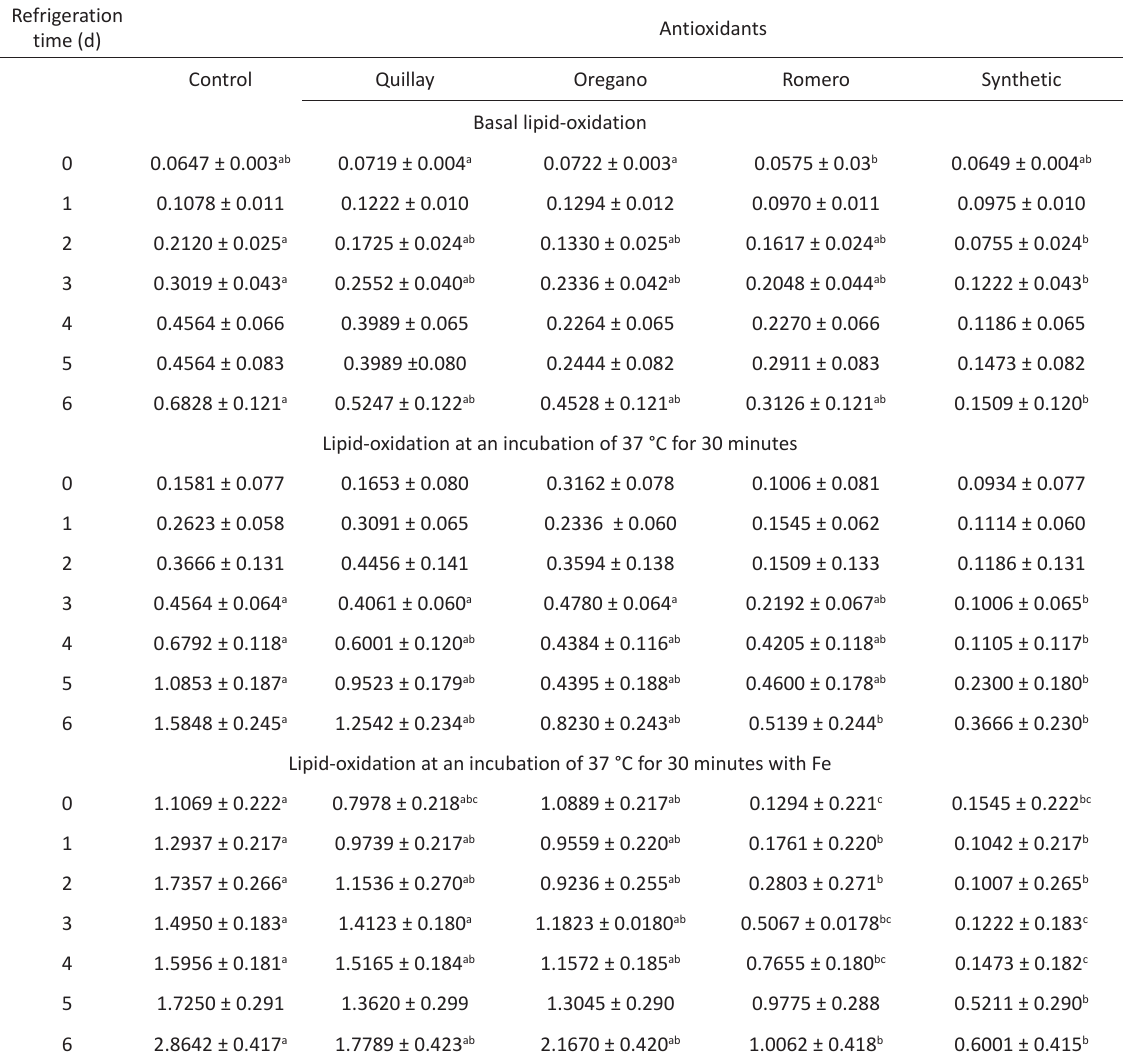
Table 3. TBARS values (µg MDA g -1 of tissue) obtained with equivalent dose and with 4% absorption of marinade measured in the NQC region (average ± standard error of the mean) Refrigeration time